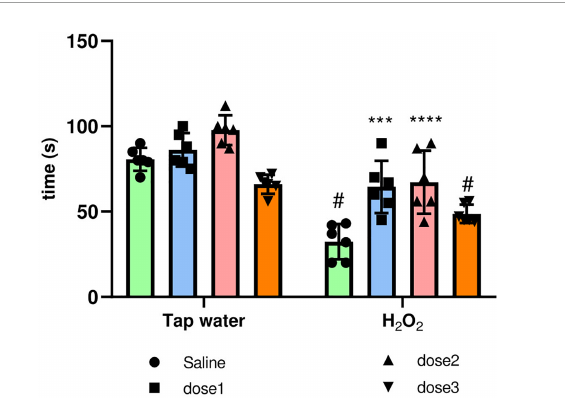
FIGURE6 Effect of the interaction between the extract treatment and the exposure to H 2 O 2 on motor coordination assessed by the rotarod test. The time spent on the cylinder was calculated. The results were presented as mean ± SD ( n = 6). Data were analyzed by Two-ways ANOVA followed by Bonferroni’s post-hoc test; *** p ≤ 0.001, **** p ≤ 0.0001 compared to saline group in the same